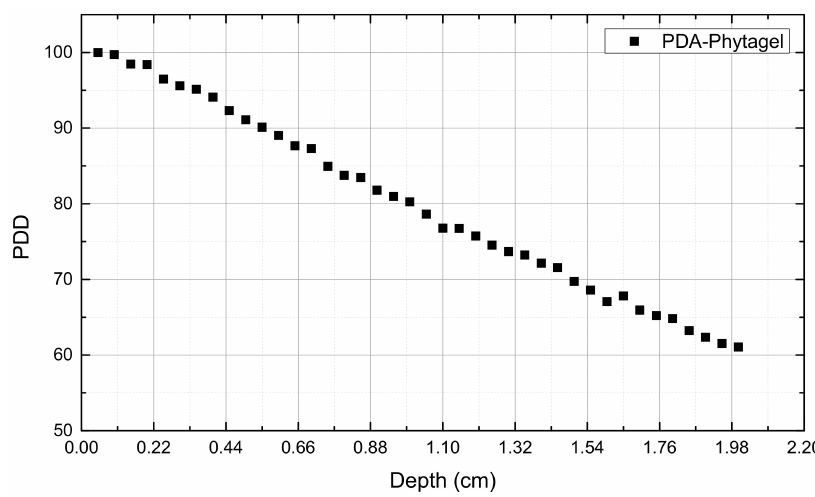
Figure 8. The simulation results for the PDD curve of the PDA-Phytagel dosimeter.